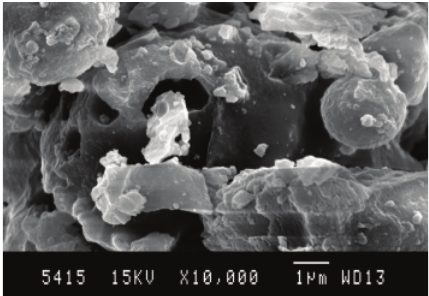
Figure 3: SEM photograph of untreated red mud. Figure 4: SEM photograph of sintered red